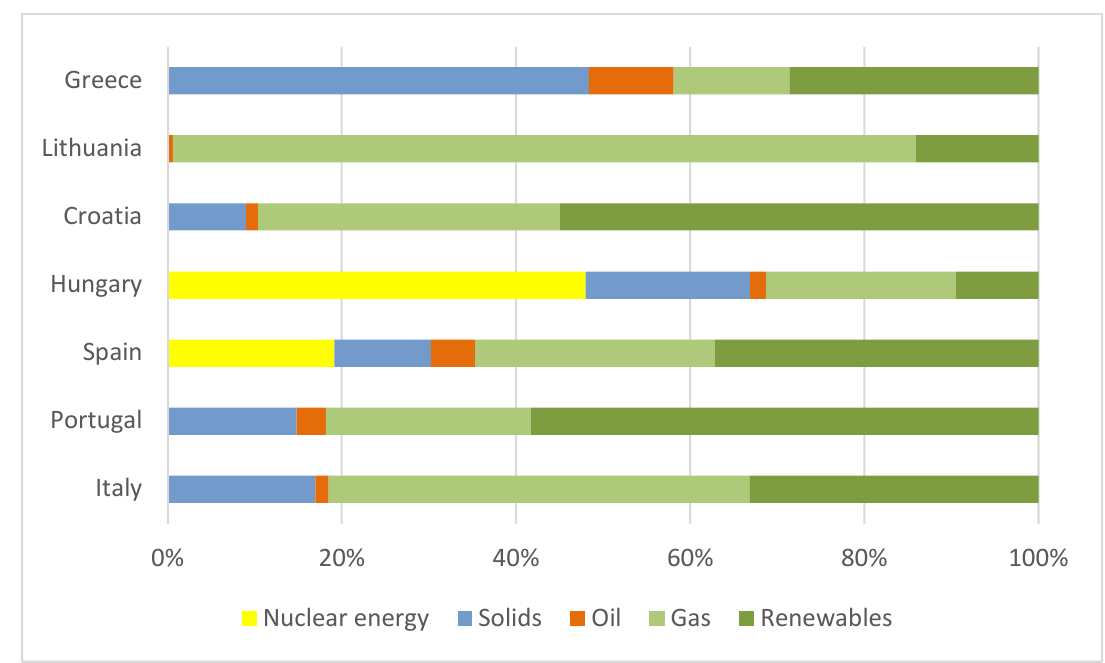
12 of 18 Figure 7. Structure of energy mixes for the first and second clusters. Source (own elaboration).